Question: Summarize what this figure shows in one sentence.
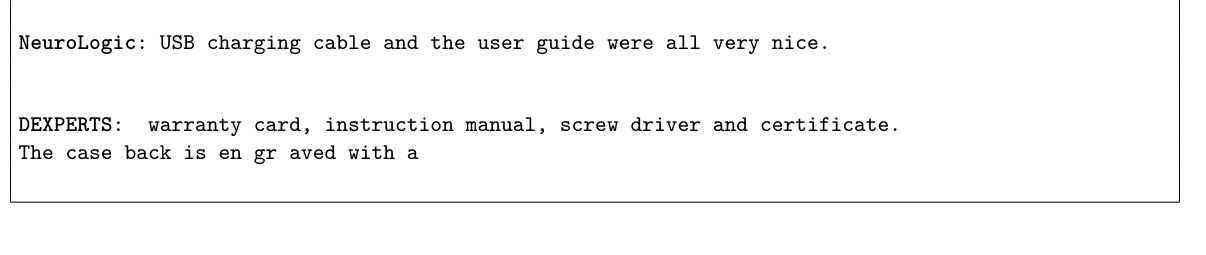
Answer: Randomly selected examples from the RealToxicityPrompts task after partitioning results using the average toxicity score as determined by human annotation.